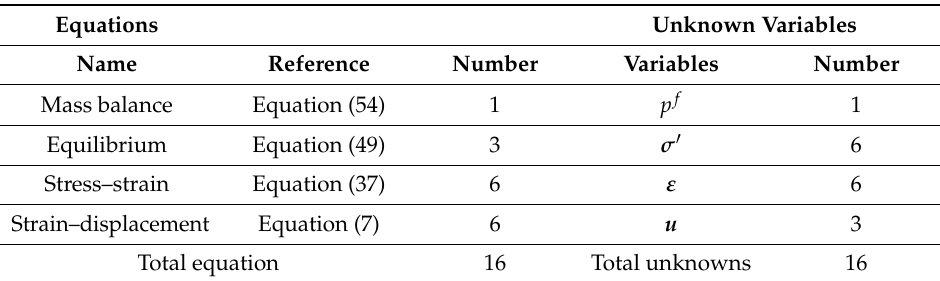
Table 2. Balance equations, constitutive relations and the unknown